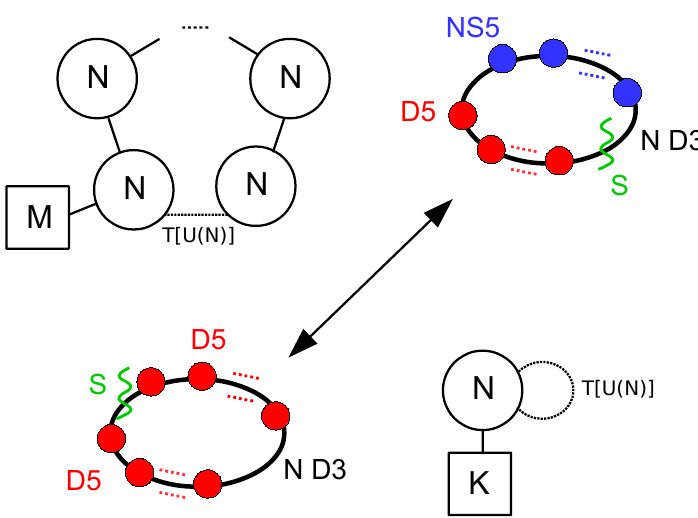
Figure 10 . Quiver with gauge group U( N ) c M +1 , M fundamental hypermultiplets and a T [U( N )] link. The corresponding brane realization has c M NS5s, M D5s and an S interface. After moving the S interface we can reach a description with K = M + c M D5s, corresponding to a simpler quiver theory (pure D5 dual